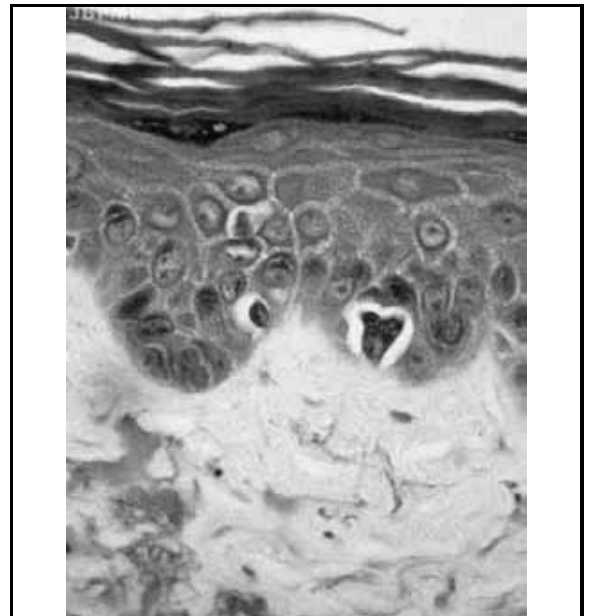
Figura 6 – Atipia citológica. Hematoxilina e eosina (1.000x)